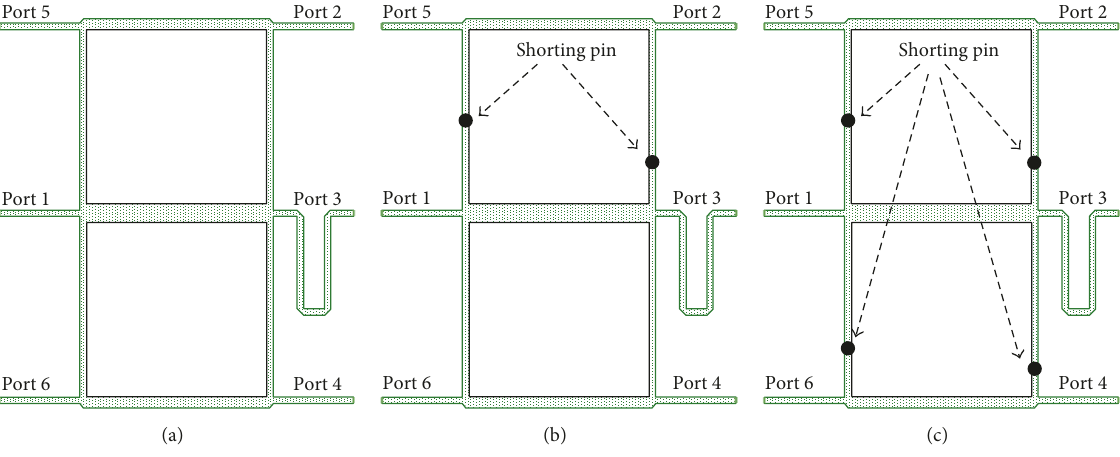
Figure 1: The couplers designed with (a) 0, (b) 2, and (c) 4 shorting